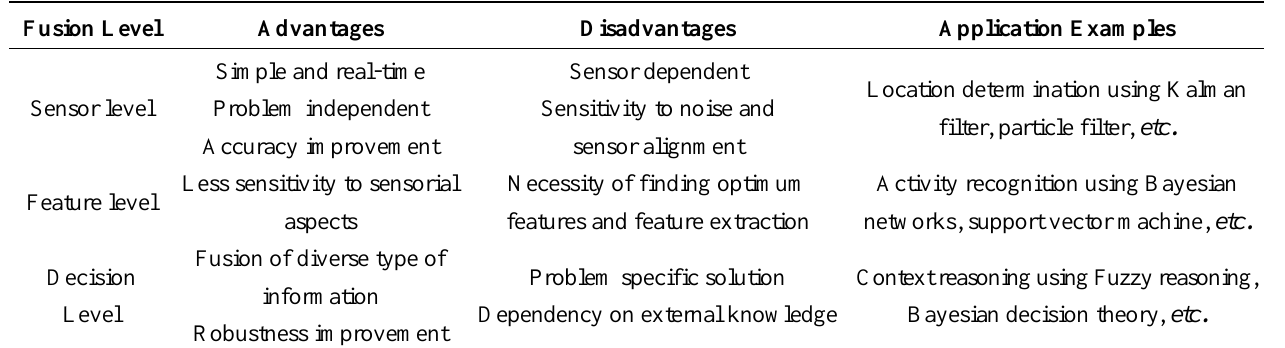
Table 1. Comparison of three different levels of fusion.